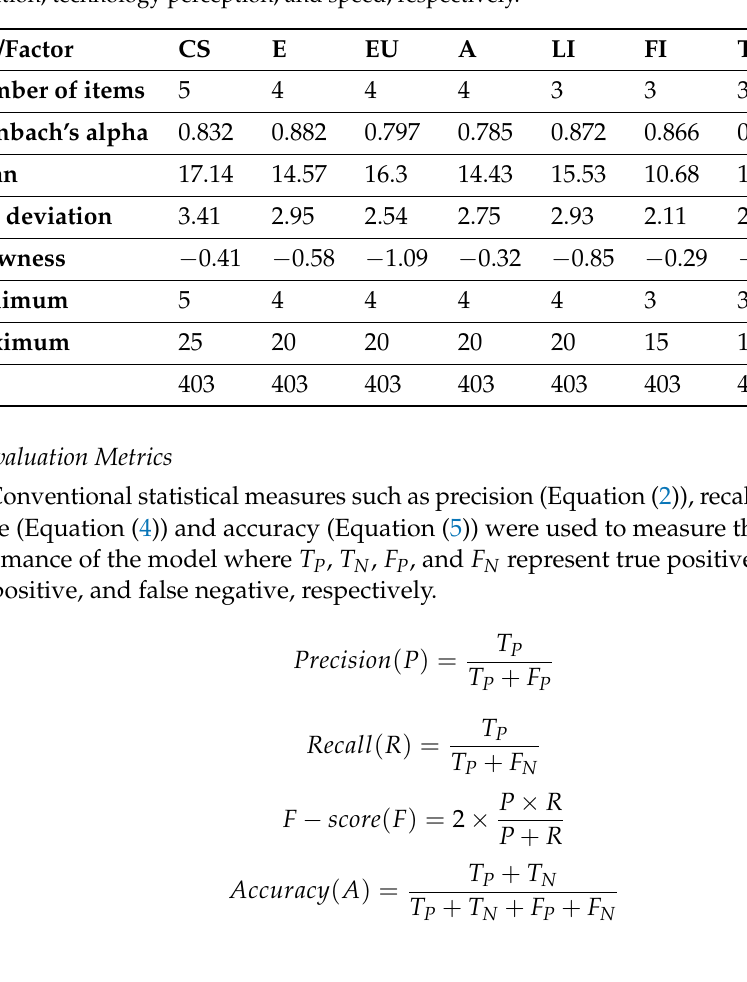
Table 6. Summary measures of eight factors to measure customer satisfaction. CS, C, EU, A, LI, FI, TP, and S represent customer service, compatibility, ease of use, assurance, loyalty intention, firm innovation, technology perception, and speed,